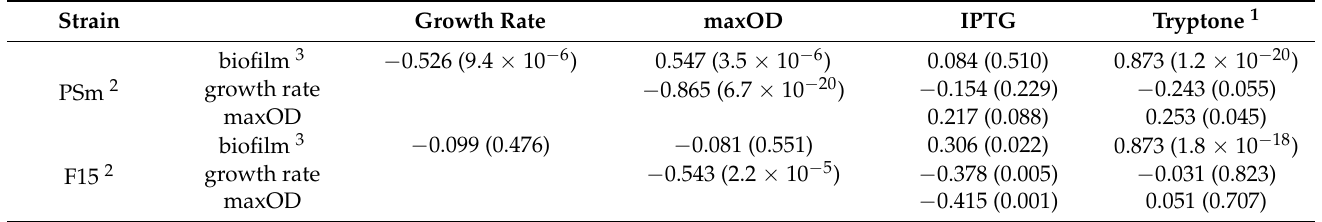
Table 1. The Spearman correlation analysis for growth parameters, biofilm, IPTG, and tryptone for P. putida strains PSm and F15. P -values are shown in